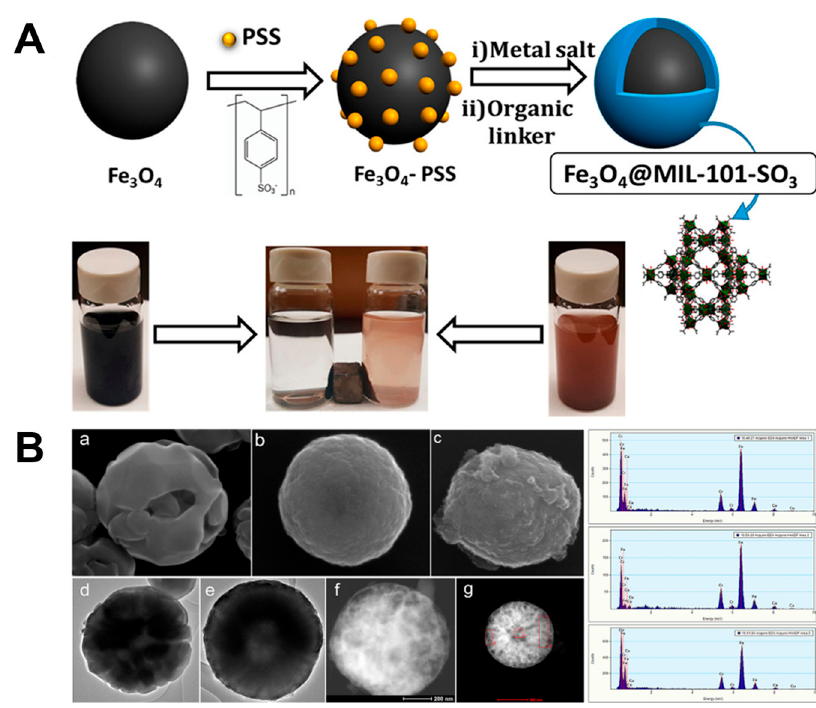
Figure 8. ( A ). Schematic representation of the Fe 3 O 4 @MIL-101-SO 3 core formation. ( B ). SEM, Transmission Electron Microscope (TEM), and Energy Dispersive X-ray (EDX) studies of the magnetic core-shell microsphere. ( a – c ) SEM images of Fe 3 O 4 , Fe 3 O 4 –PSS, and Fe 3 O 4 @MIL-101-SO 3 . ( d – f ) TEM images of Fe 3 O 4 , Fe 3 O 4 –PSS, and Fe 3 O 4 @MIL-101-SO 3 . ( g ) TEM and corresponding EDX data showing